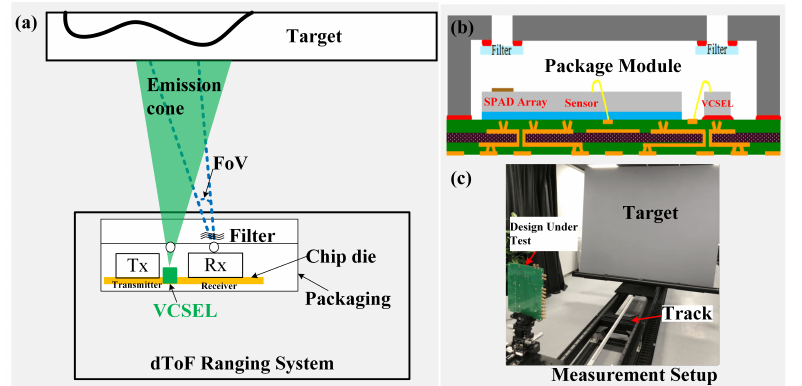
Figure 1. The designed dToF ranging system: ( a ) The working principle of dToF. ( b ) The package module of the ranging system. ( c ) The measurement setup of the ranging system.